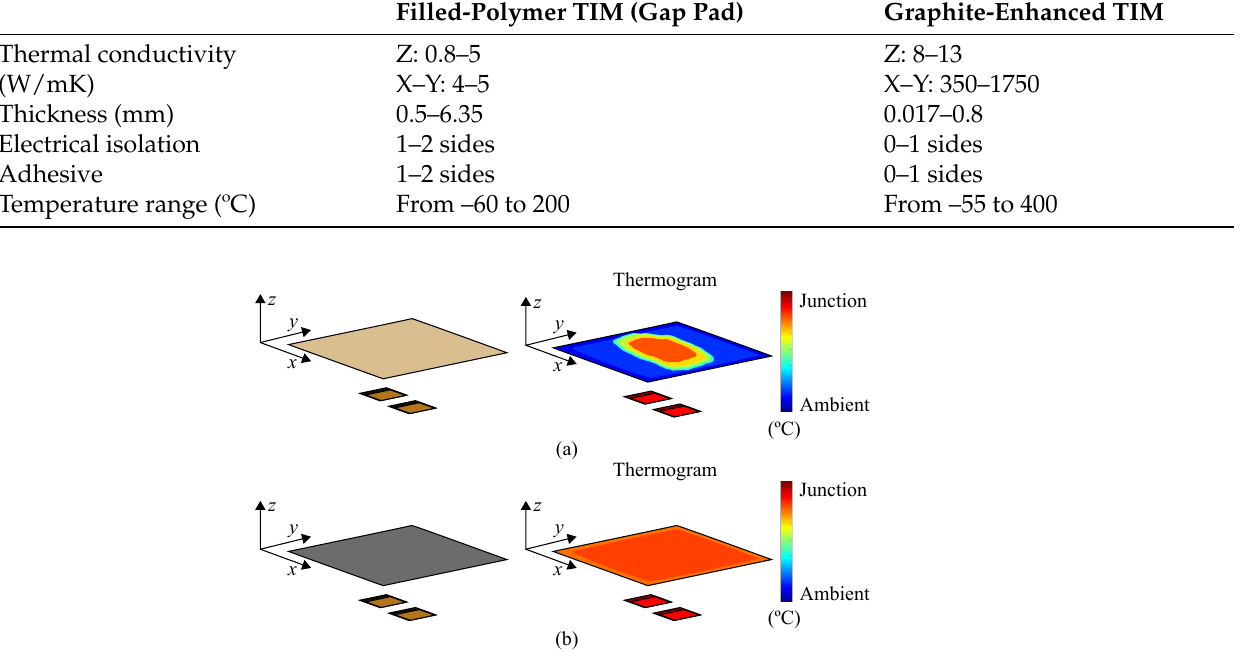
Figure 3. Representation of heat flow through: ( a ) a polymetric TIM; and ( b ) a graphite- enhanced